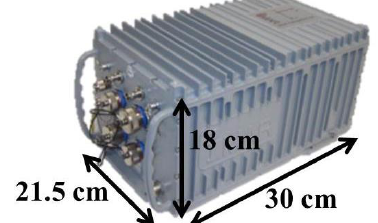
Figure 1. The UAS platform developed for gravimetric